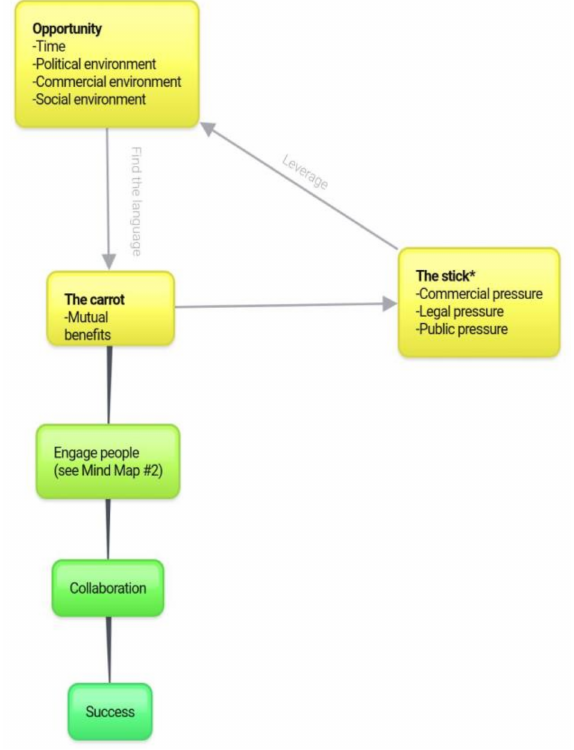
Figure 4. The case of the carrot vs the stick. * Asterisks highlights ‘the stick’ as an outlying strategy presented in the data, but one that was suggested to have use in specific circumstances, presented